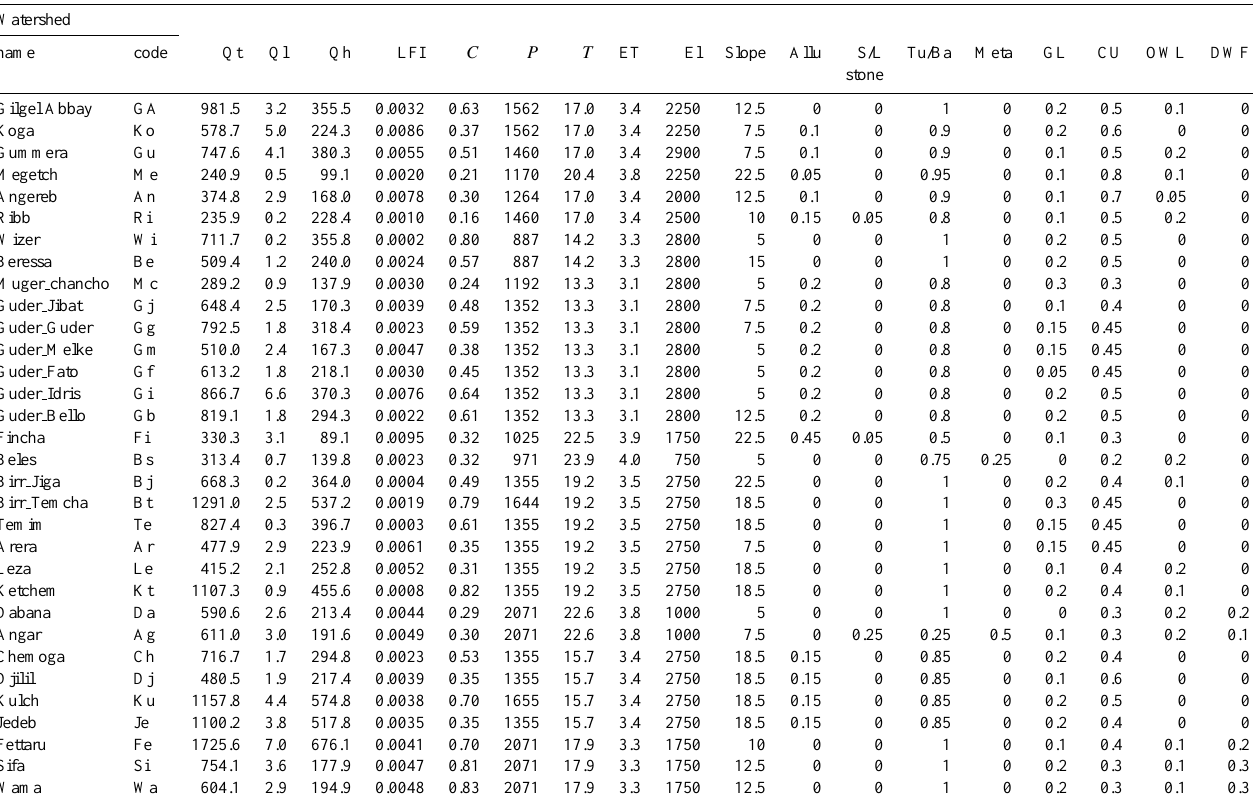
Table 1. Watersheds and their respective variables, as extracted from the USBR document (US Department of Interior, 1964) a .